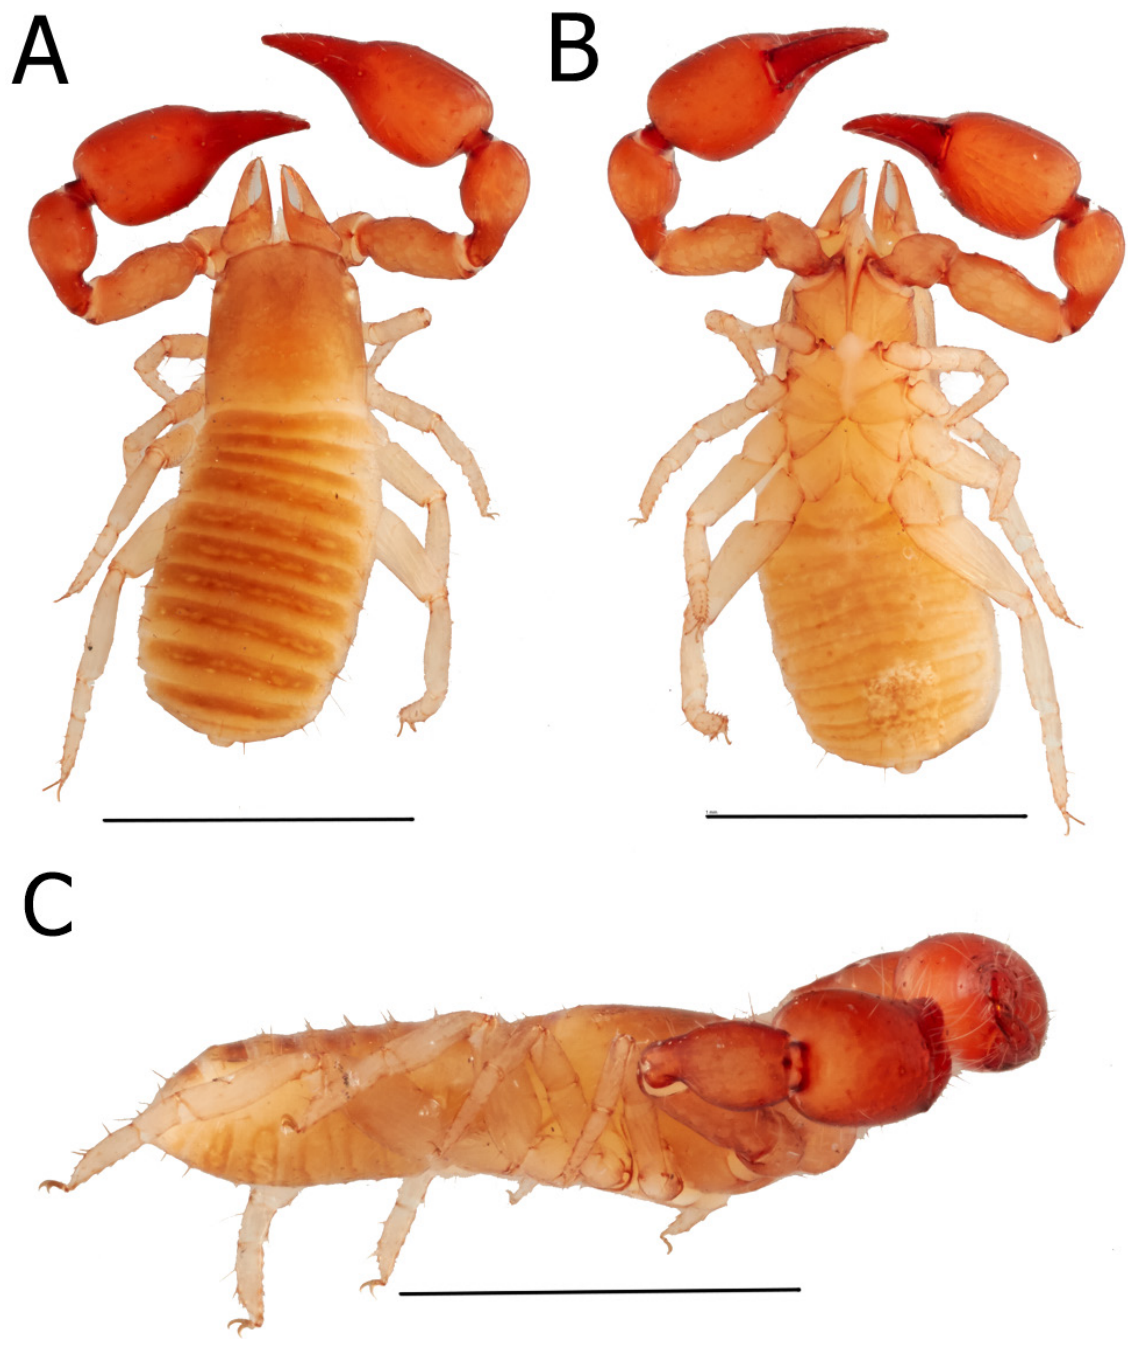
Fig. 10. Ideobisium sonqo sp. nov., ♀, allotype (QCAZ). A . Habitus in dorsal view. B . Habitus in ventral view. C . Habitus in lateral view. Scale bars = 1